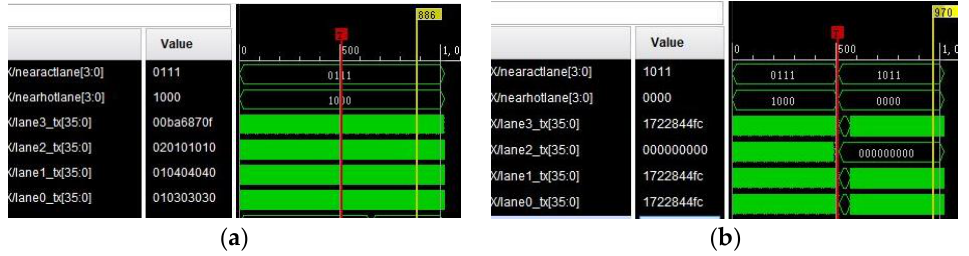
Figure 10. The ILA waveforms of hot redundancy in different stages. ( a ) A hot redundant lane sends PRBS words; ( b ) a hot redundant lane is promoted to a data-sending